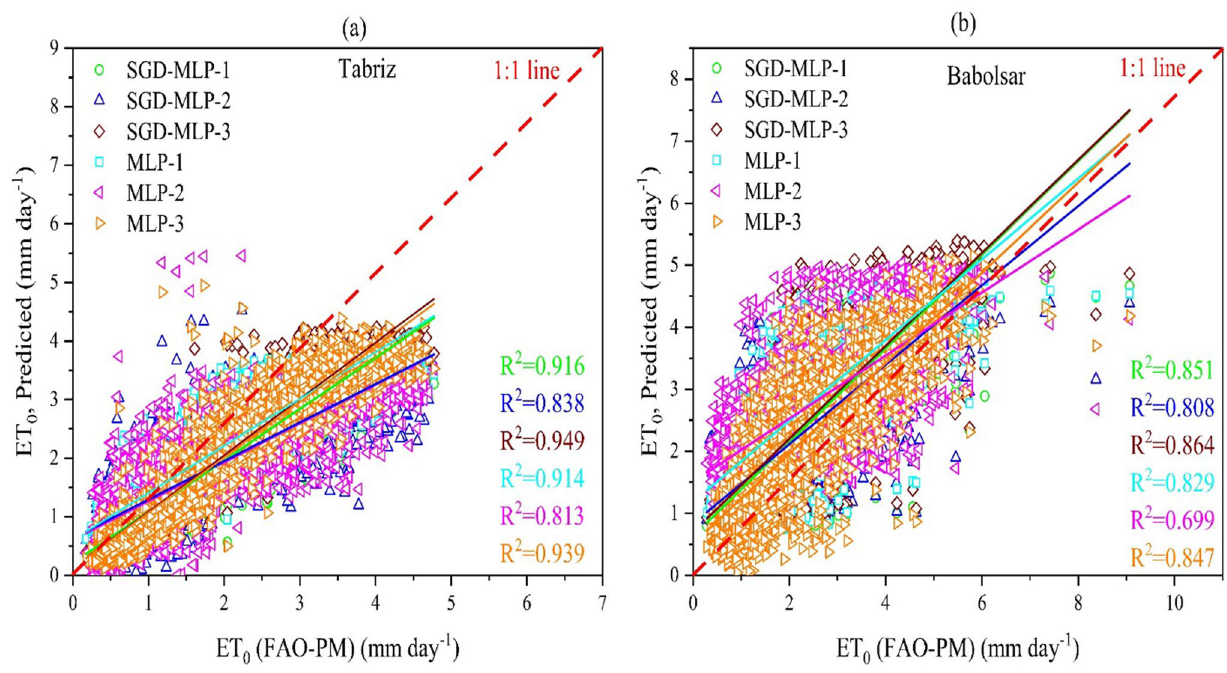
Fig. 4 FAO-PM vs. estimated daily ET0 values by the SGD-MLP and MLP algorithms during the testing period (2017–2021) at Tabriz and Babolsar station